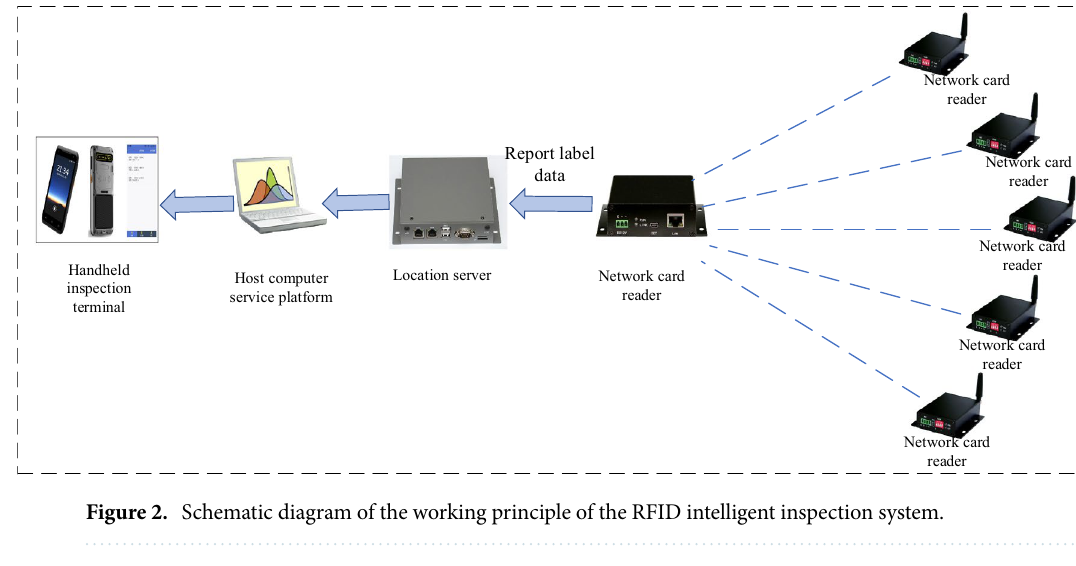
Figure 2. Schematic diagram of the working principle of the RFID intelligent inspection system.